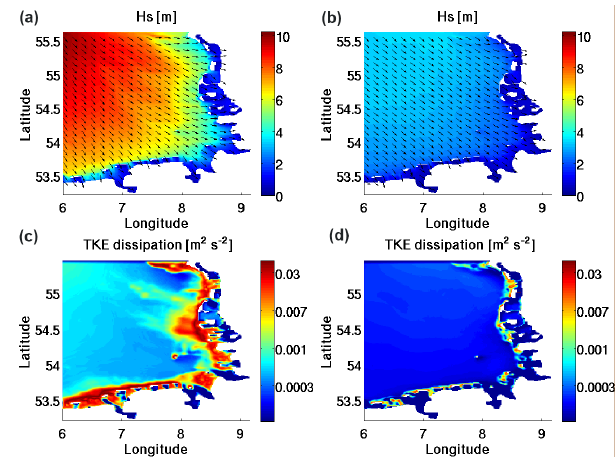
Figure 7. (a) Significant wave height (m) in the German Bight dur- ing the peak of storm Britta on 1 November 2006 at 03:00UTC. (b) Significant wave height (m) in the German Bight during nor- mal meteorological conditions on 3 November 2006 at